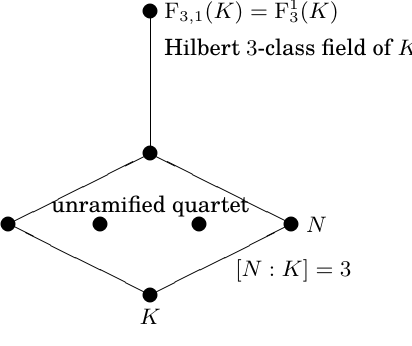
Figure 7: Hilbert class field over K